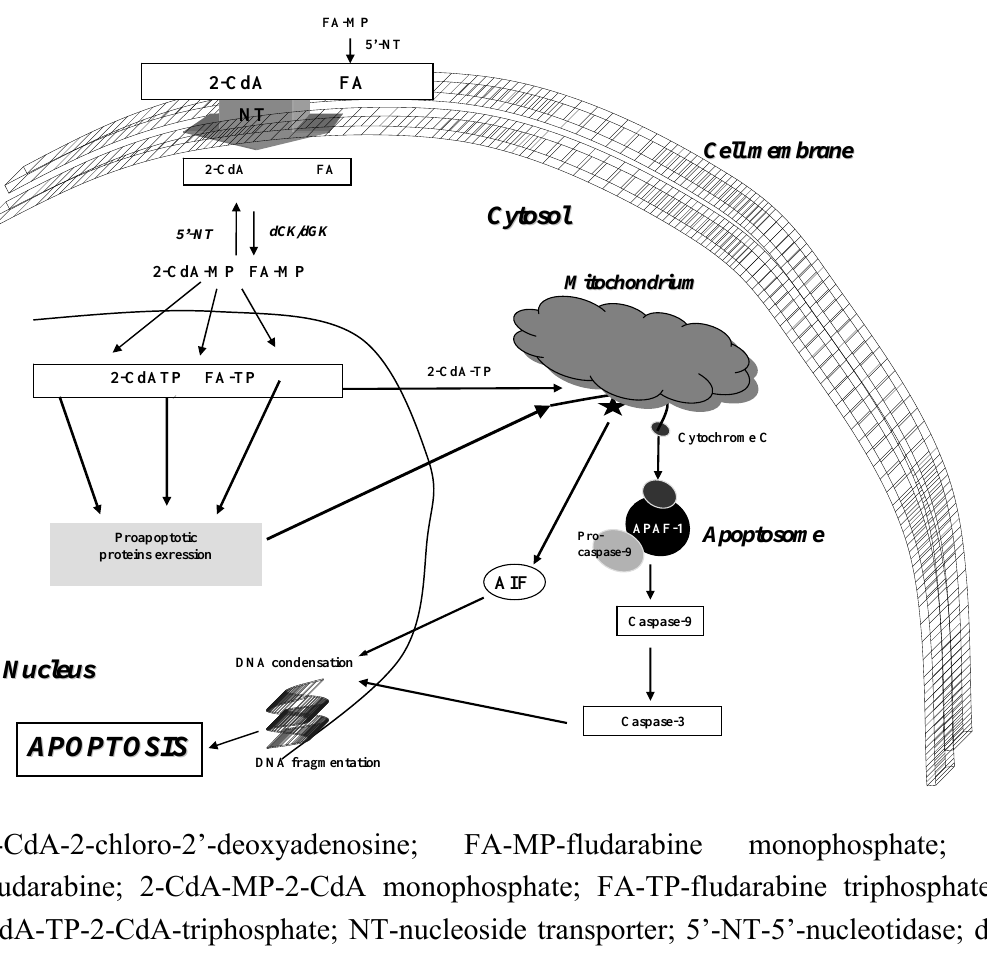
Figure 3. Mechanism of 2-CdA and FA